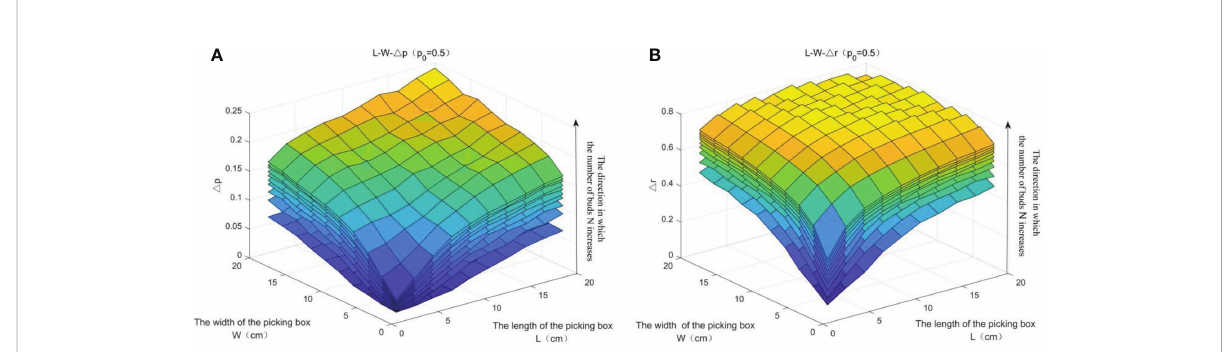
FIGURE 14 The relationship of D p and D r with the parameters W , L , and N. (A) The relationship of D p with the parameters W, L, and N. (B) The relationship of D r with the parameters W, L, and